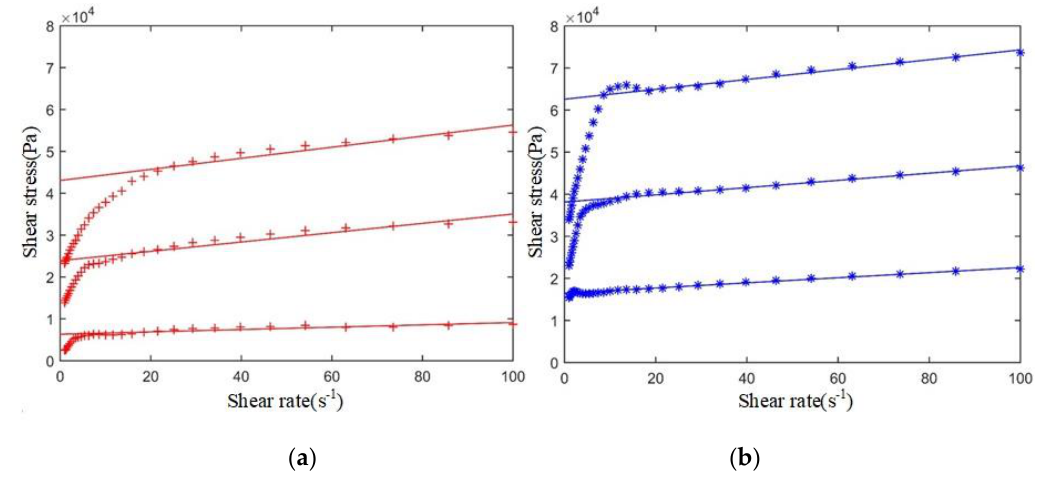
Figure 6. The simulated curve between shear stress and the shear rate at different magnetic flux densities. ( a ) sample 1. ( b ) sample 3.